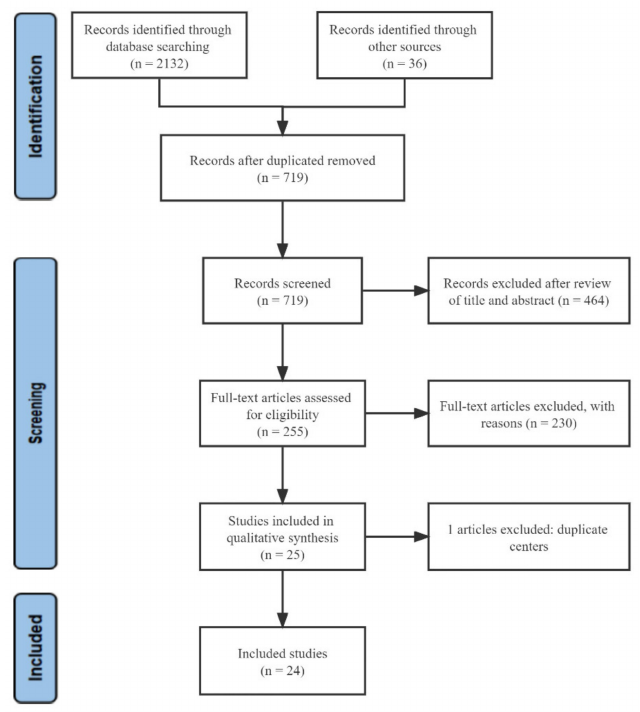
Figure 1. Flow diagram of the selection